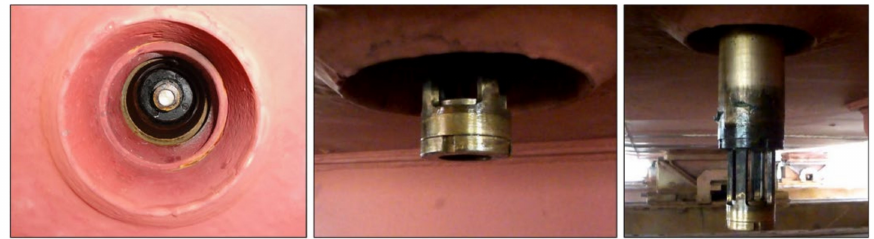
Figure 17. The new location of under-keel sound velocity sensor.